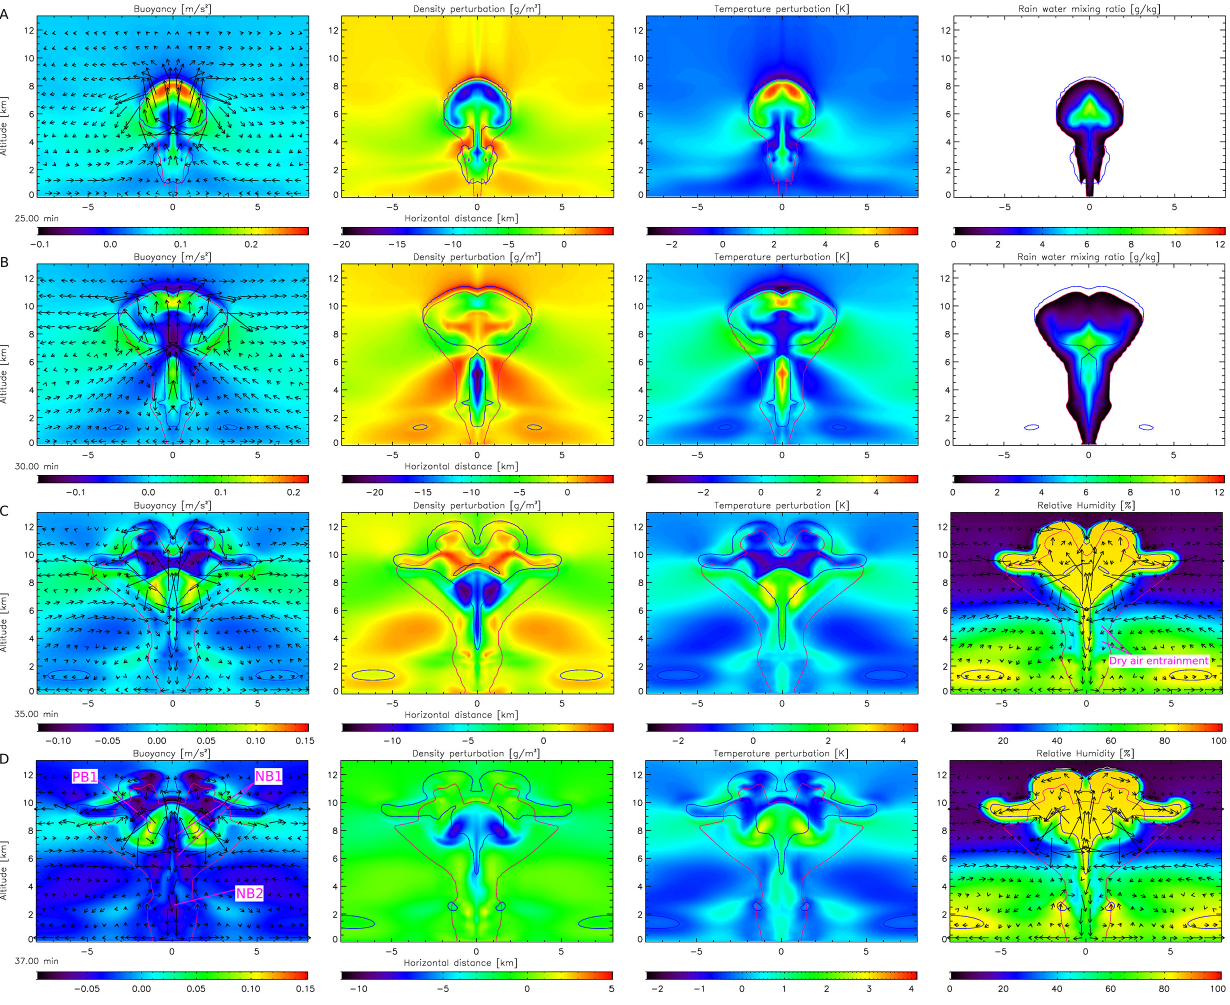
Fig. 3. Idealized benchmark simulations ( 0 = 3 . 5Kkm − 1 ). Vertical cross section, between 0 and 13km altitude, of buoyancy [ms − 2 ], density perturbation [g m − 3 ], temperature perturbation [K] and rain water mixing ratio [gkg − 1 ] at t = 25 (A) , 30 (B) , 35 (C) , 37 (D) , 40 (E) 42 (F) , 45 (G) , 50 (H) and 55 (I) min. Note that color scale is different for each image. Perturbation is defined as the difference between local value and domain average, at fixed altitude. Wind vectors are overplotted on first image. The length of an arrow is proportional to wind intensity (1km in spatial reference system scale is equal to 5ms − 1